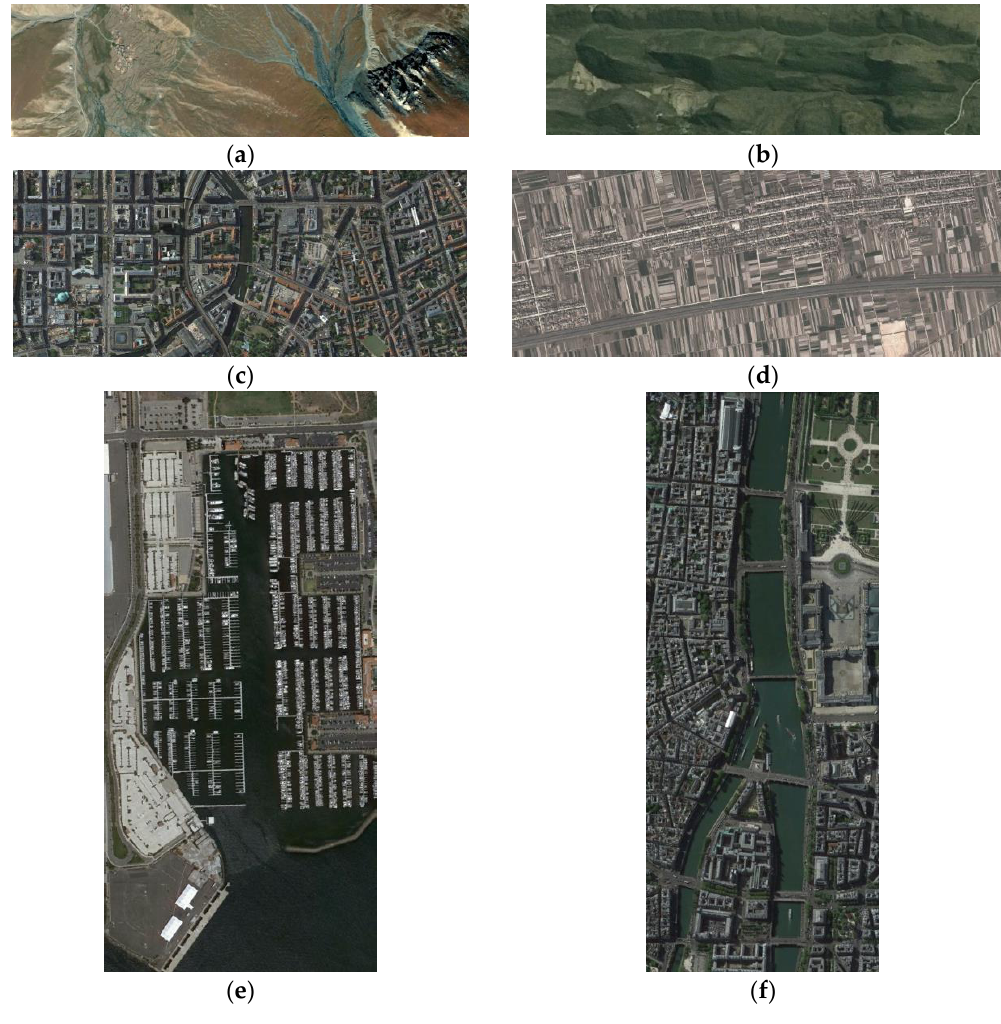
Figure 8. Examples of non-airport objects.